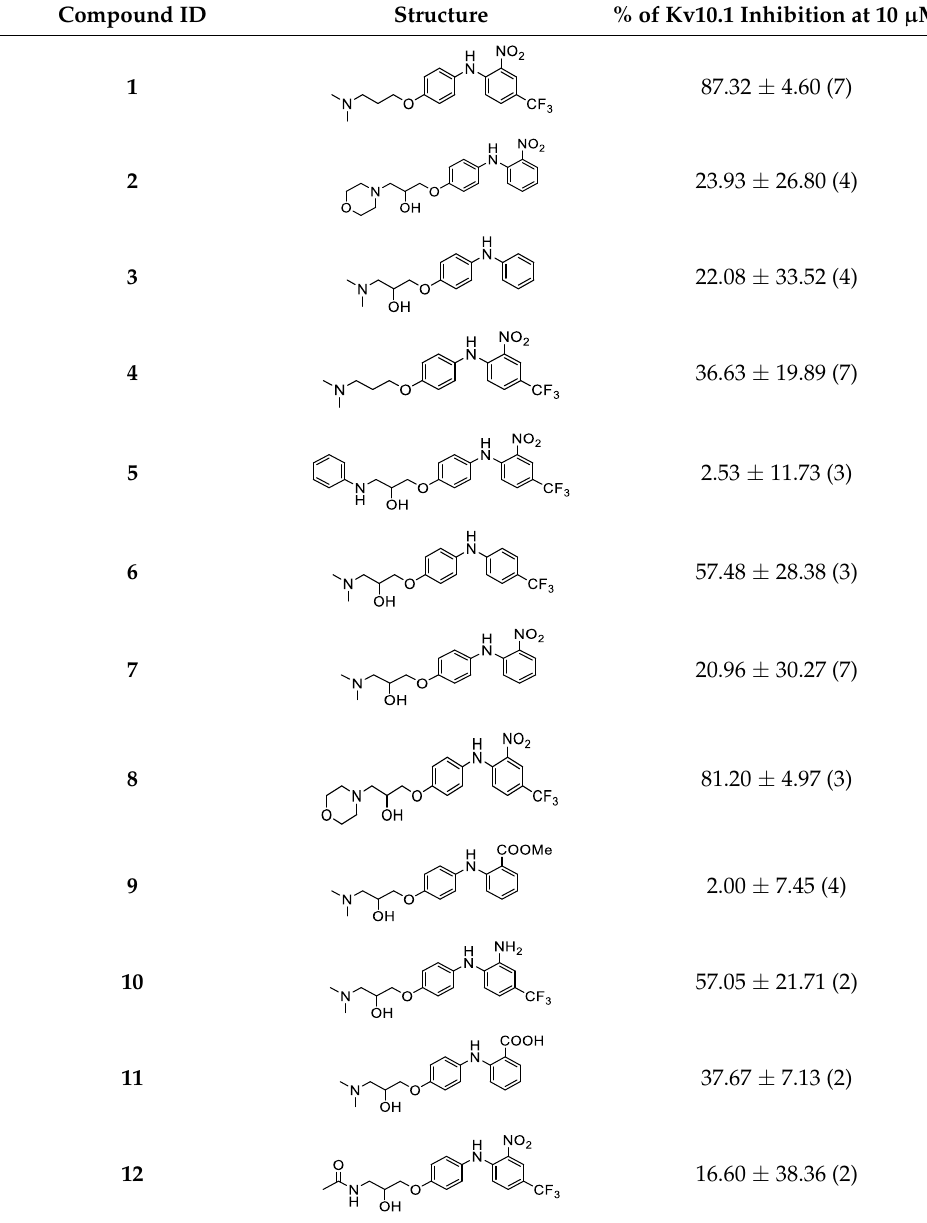
Table 3. Structures and potencies of the designed and synthesised ZVS -08 analogues 1–12 .